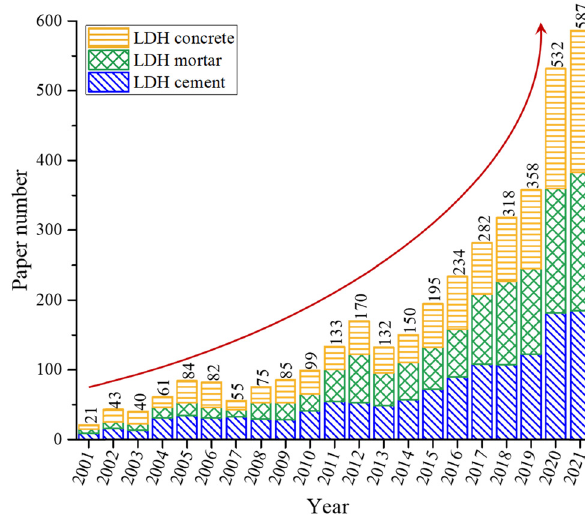
Figure 1: Number of research studies with keywords of LDHs cement, LDHs mortar, and LDHs concrete in the past 20 years ( Elsevier database )